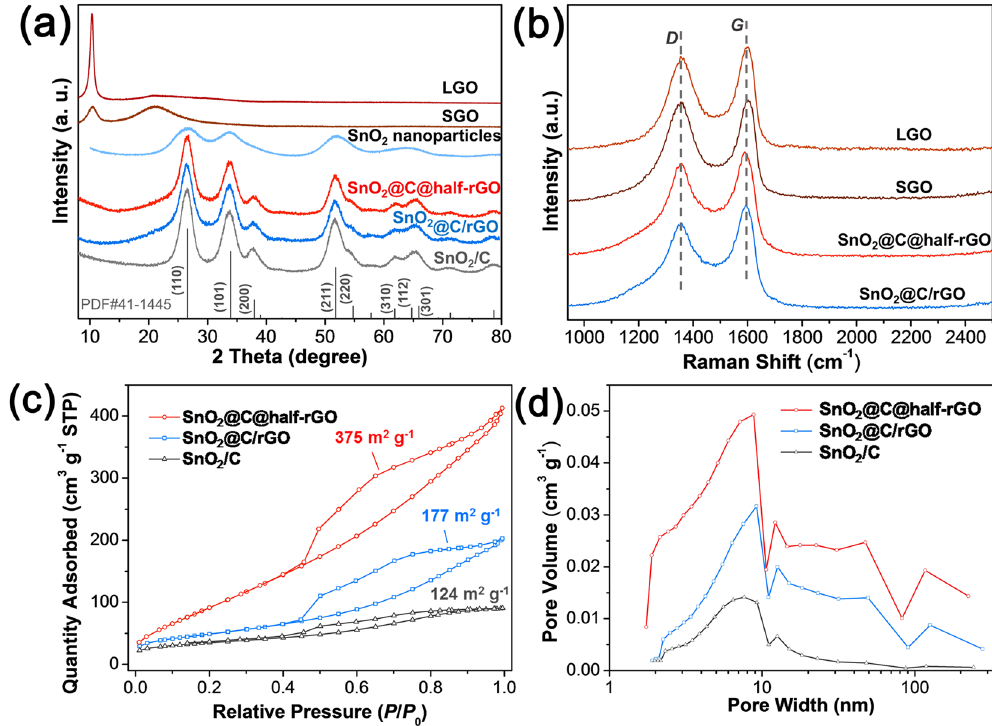
Figure 3. ( a ) XRD patterns of LGO, SGO, SnO 2 nanoparticles, SnO 2 @C@half-rGO, SnO 2 @C/rGO, and SnO 2 /C. The standard peak position and intensity of PDF#41-1445 SnO 2 are shown as verticle lines. ( b ) Raman spectra of LGO, SGO,